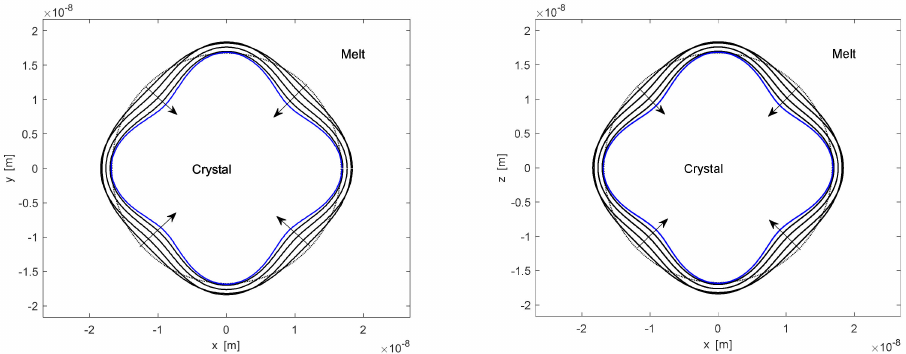
Figure 1. The cross-sectional curves of the interface morphology of the particle under the influence of anisotropic interface kinetics at different times t = 0,0.2,1.0,2.0,3.0,4.5 (from outside to inside), where β = 0.25, r 0 = 1.1 R ∗ , Γ = 0.4545, ∆ T = 10. By contrast, the dashed line denotes the interface without the anisotropic effect of interface kinetics.